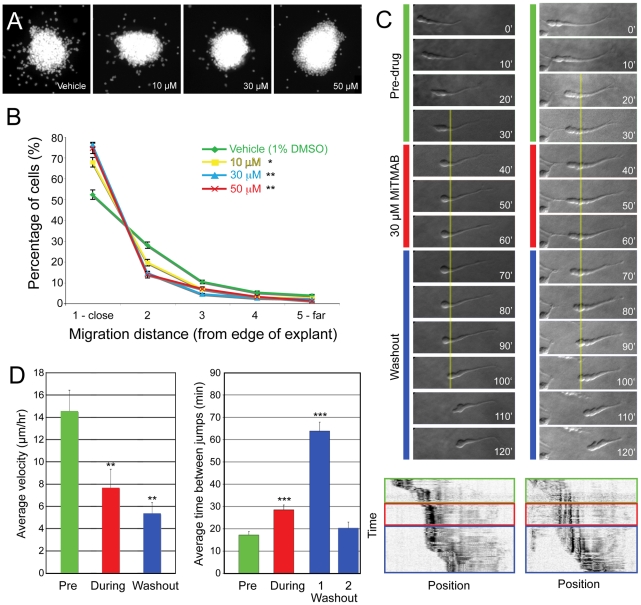
Inhibiting dynamin impairs SVZa neuron migration.(A) Images of explants treated with varying concentrations of MiTMAB. Fewer DAPI-stained nuclei are present outside explants at increasingly higher concentrations of MiTMAB. (B) Effect of MiTMAB treatment on the percentage of cell nuclei present in evenly-spaced concentric rings surrounding the explant at increasing distances. (C) Time-lapse series of two neurons treated with MiTMAB. The yellow line marks the position of the dilation at the time of MiTMAB addition, which becomes that of the cell rear after washout. (Bottom) Kymographs plotting time vs. position highlight the positions of the cell rears. See Movies S2, S3. (D) Average velocity (µm/hr) of neurons migrating before the addition of MiTMAB is significantly faster than that in the presence of the drug or after washout (n = 19). The amount of time a cell spends in the same position between translocations is significantly longer before the first translocation after washout (Washout-1, n = 16) compared to either before (Pre, n = 15) or in the presence of MiTMAB (During, n = 13). Cells that made additional translocations during washout (Washout-2, n = 6) showed inter-translocation interval values similar to those before MiTMAB addition. Data presented as mean ± SEM, *p<0.05, **p<0.01, ***p<0.001, Student's t-test.